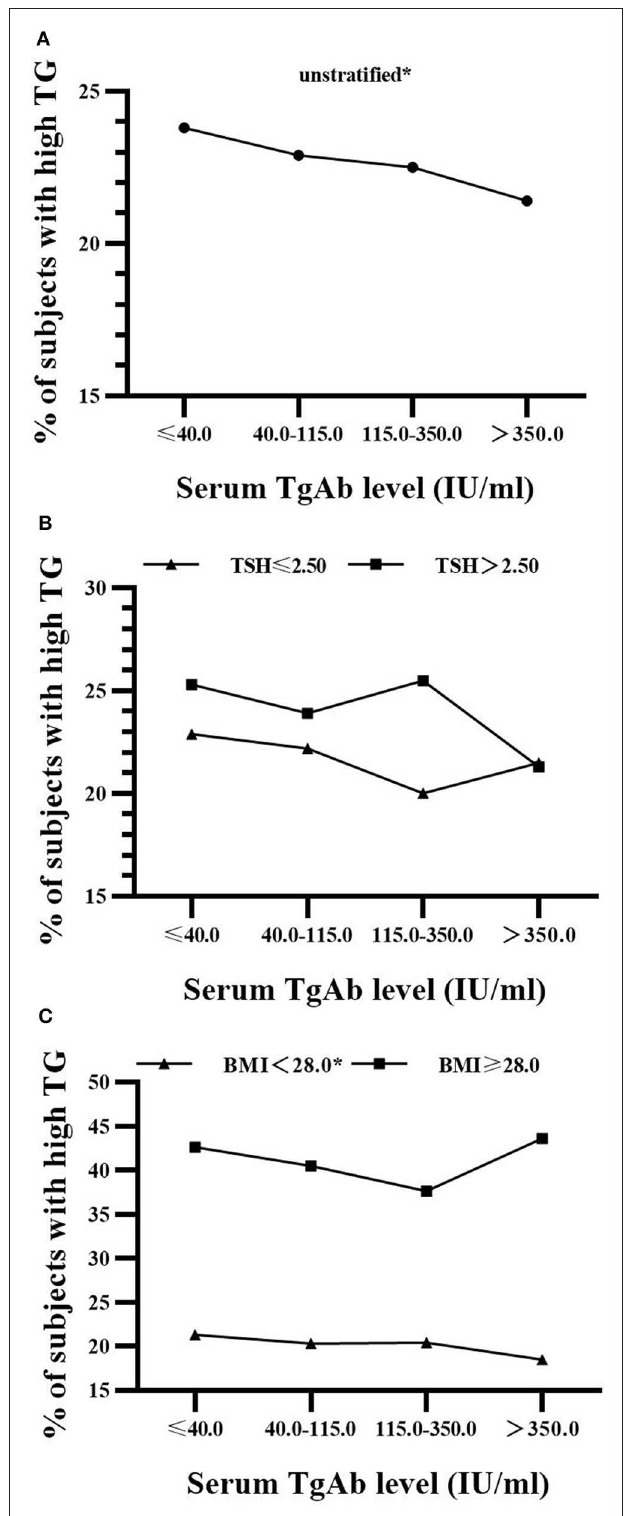
FIGURE 3 | Serum TgAb level and the percentage of subjects with hypertriglyceridemia in women (A) Serum TgAb level and the percentage of